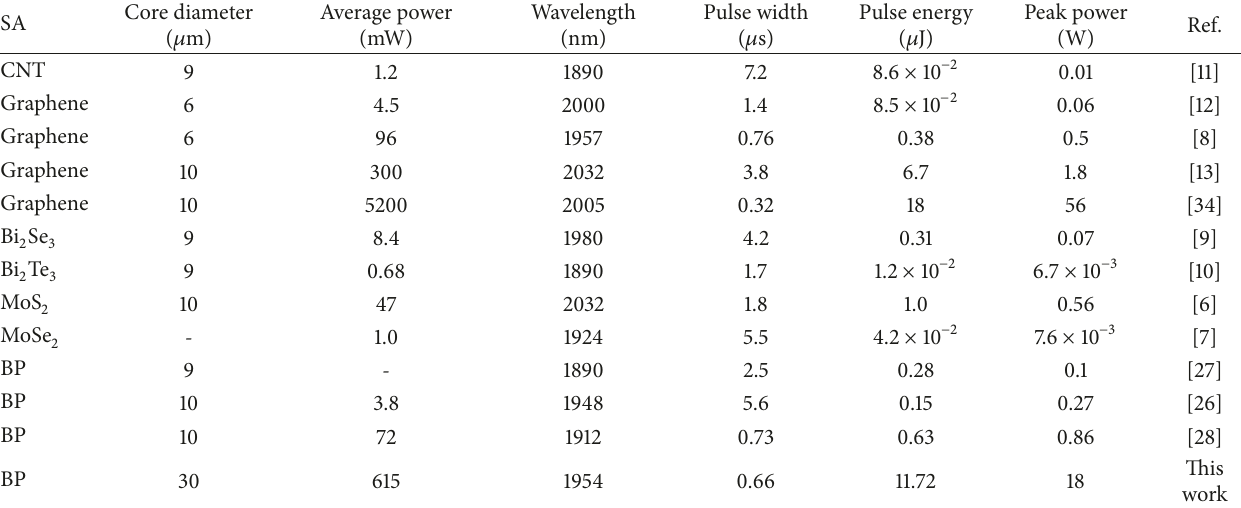
Table 1: Passively Q-switched Tm-doped and Tm/Ho-co doped fiber lasers based on low dimensional SAs.